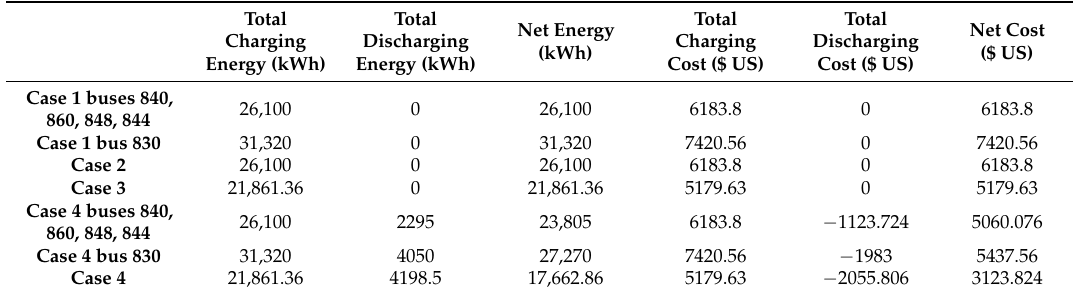
Table 10. Summary of the different Cases Charging and Discharging